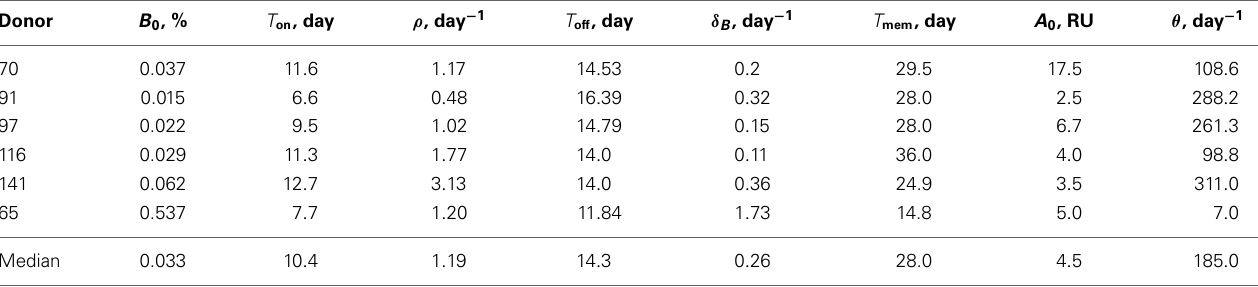
Table 2 | Parameter estimates determining the kinetics of VV-specific antibody-secreting cells and antibodies. Donor B 0 ,